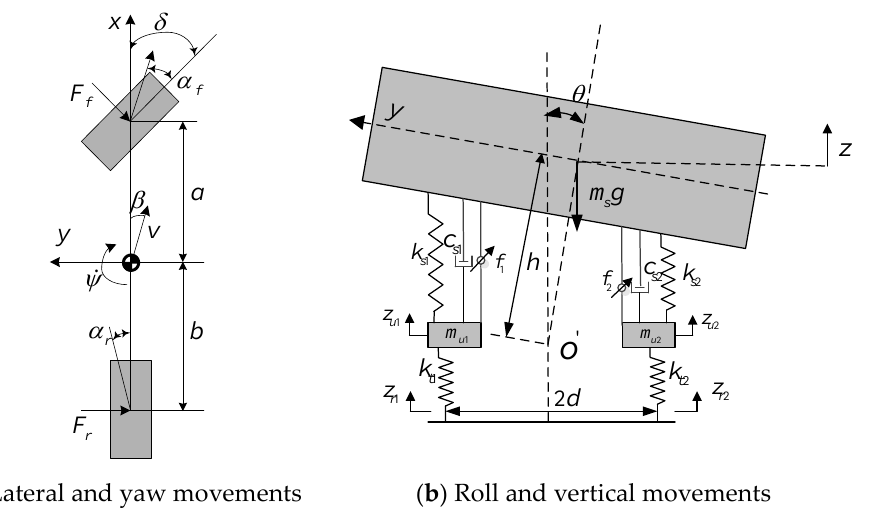
Figure 1. Steer–roll dynamic model of the full vehicle. Vehicle steering dynamics equation: